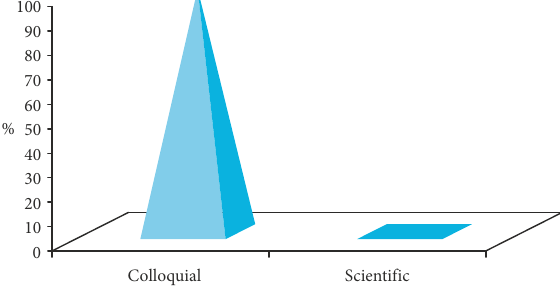
Figure 2. The results of the answers to the question “In which language style do you use the presented foreign